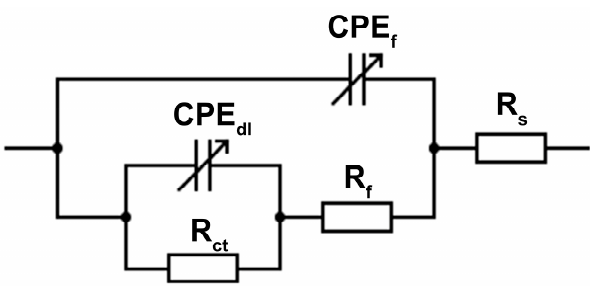
Figure 16. Equivalent electrical circuit to model EIS curves. Table 4. Results obtained from the EIS data fi tt ing.